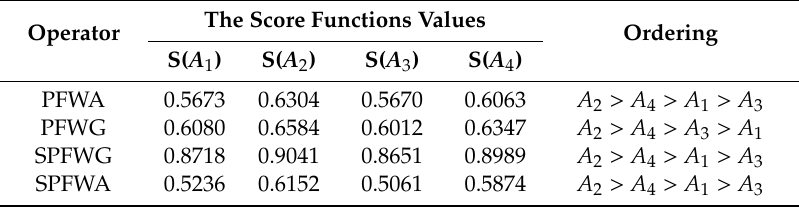
Table 4. The score functions values of all alternatives with di ff erent